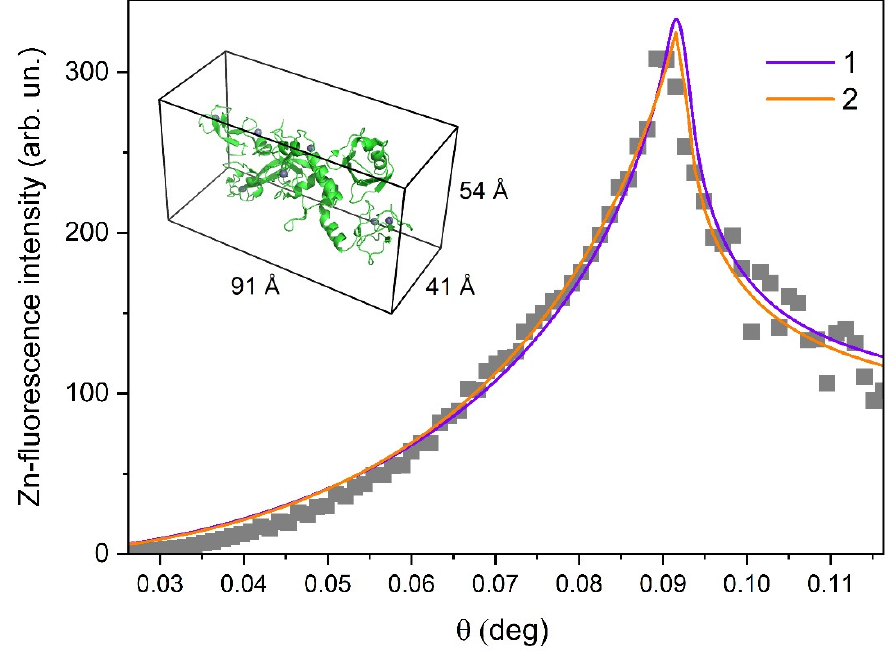
Figure 2. Experimental angular dependence of the Zn-fluorescence yield from layer of the parkin protein. The solid curves represent the angular dependences, calculated for one-layer (Curve 1) and two-layer (Curve 2) models. The three-dimensional (3D) structure of the parkin protein is shown in the insert.